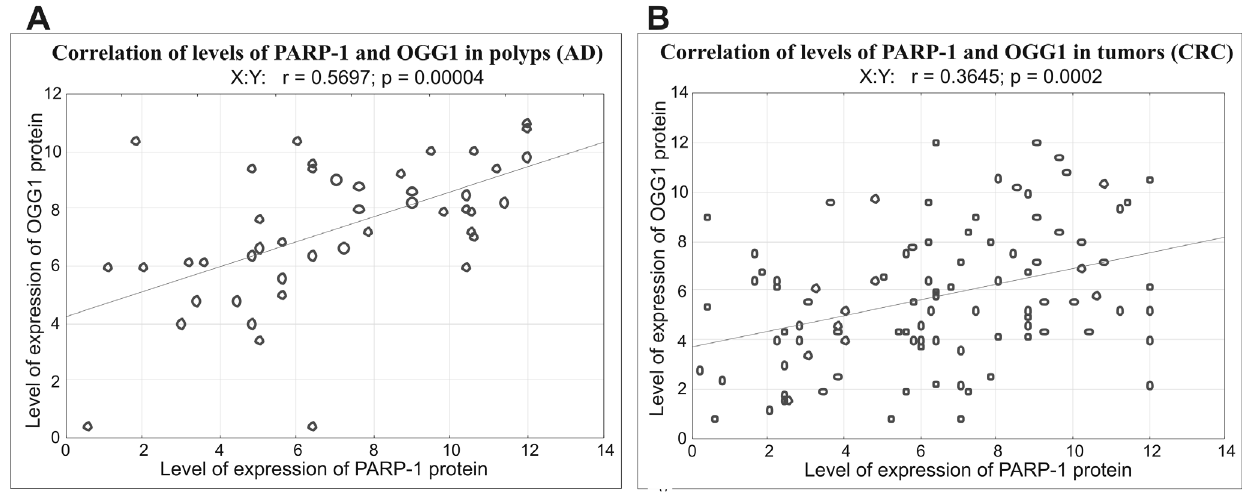
Fig. 4. Correlation between levels of expression of PARP-1 and OGG1 protein in dysplastic cells of AD (A) and CRC (B)